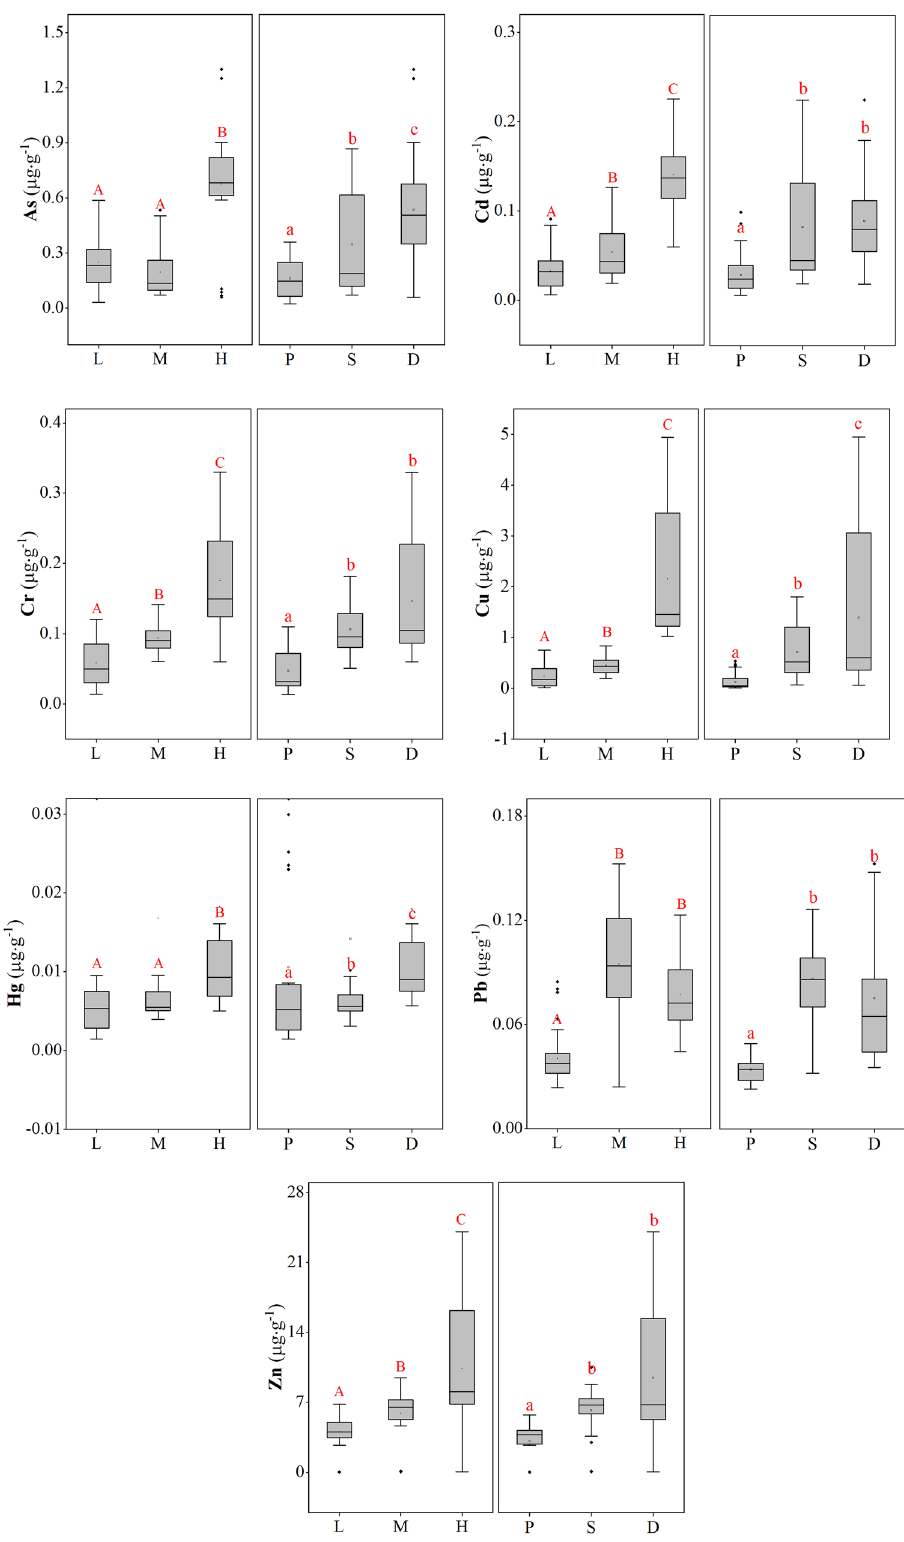
Figure 1. Trace metal contents in fish with different trophic guilds ( L low-level carnivore, M middle-level carnivore, H high-level carnivore) and habitat preferences ( P pelagic, S sub-benthic, D benthic) from Xincun Lagoon, South China